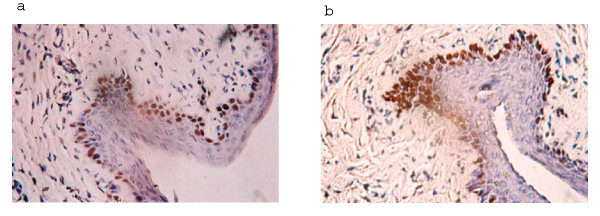
Light microscopic images of PCNA expression in (a) control (b) CAD treated rat vaginal tissue. Expression of PCNA in control (a) and CAD (82 mg/ml) treated (b) tissues. Original magnification × 200.